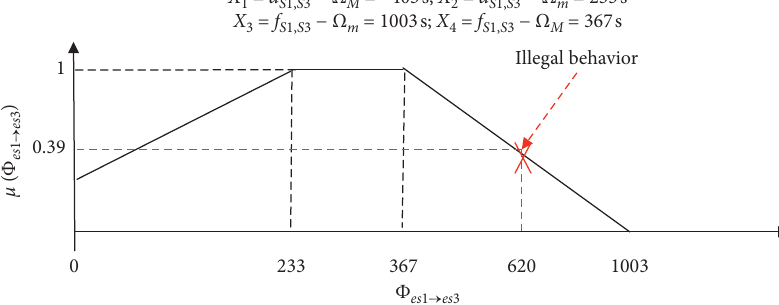
Figure 10: Possibility function considering Φ